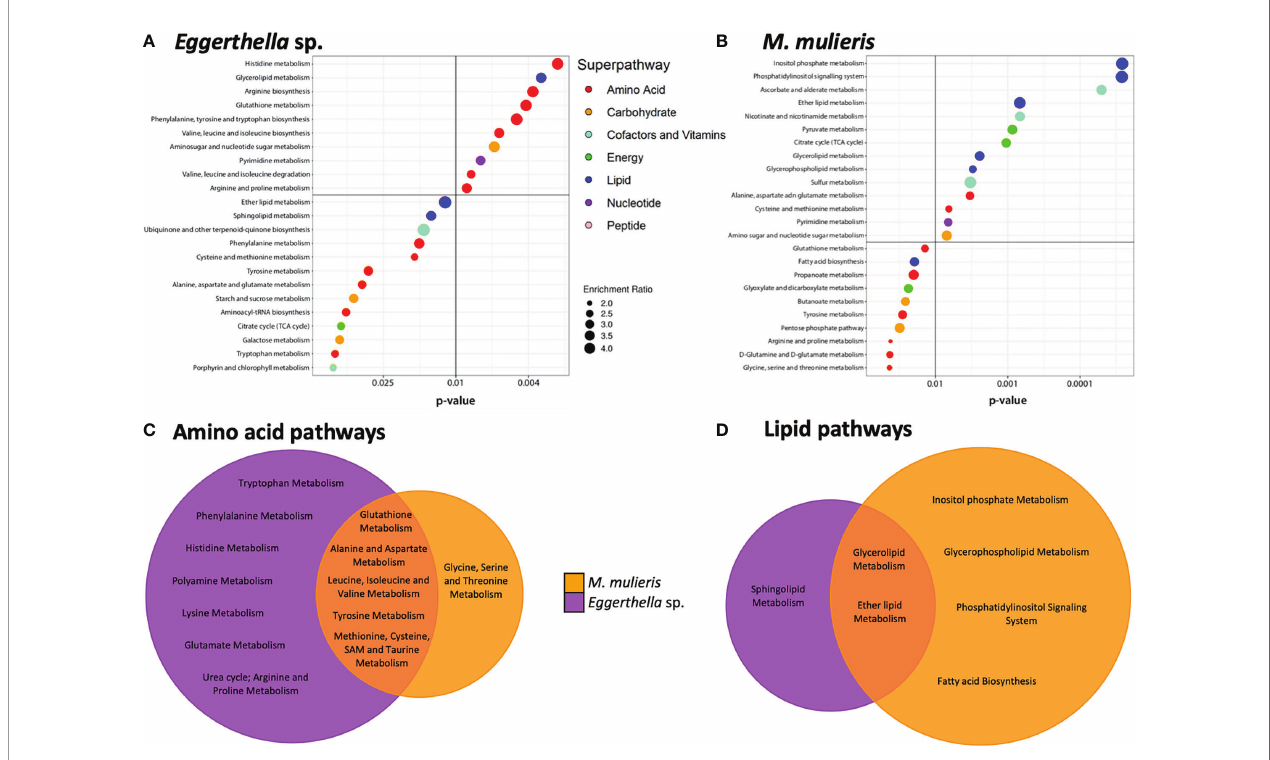
FIGURE 4 | Eggerthella sp. primarily altered amino acid subpathways whilst M. mulieris signi fi cantly altered lipid-related subpathways. Metabolic pathway enrichment analysis for (A) Eggerthella sp. MVA1 and (B) M. mulieris UPII-28I infections of 3-D cervical cell models. All subpathways shown were signi fi cantly enriched ( p <0.05) using metabolite set enrichment analysis (MSEA). Colored circles next to the subpathways indicate which superpathway each subpathway belongs to. Venn diagrams comparing the signi fi cantly altered ( p <0.05) (C) amino acid and (D) lipid subpathways by Eggerthella sp. MVA1 and M. mulieris UPII- 28I